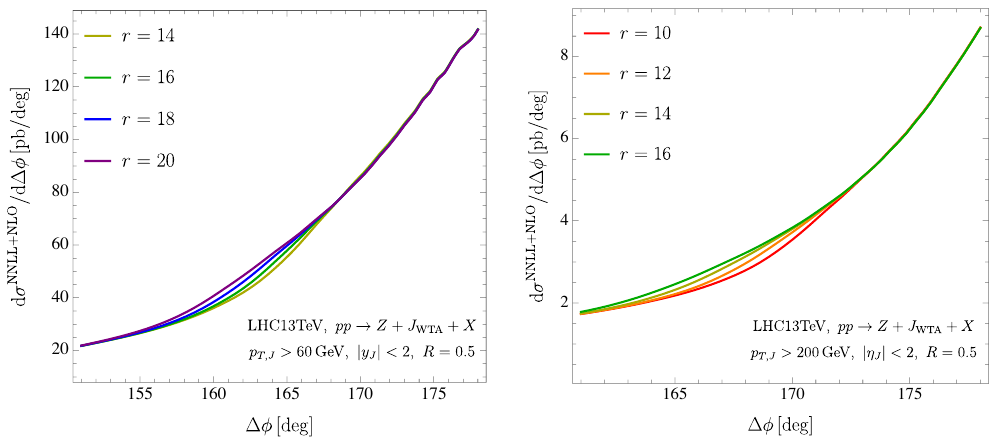
Figure 9. Varying the transition point in matching our NNLL resummation to the NLO for p T,J > 60 GeV (left) and 200 GeV